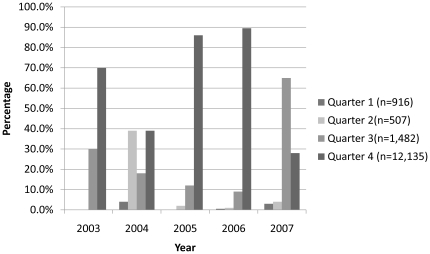
Quarterly distribution of the percentage of Dengue IgM positive cases by year.In 2003, Dengue IgM positive cases were only observed to appear in the months of July- December. This trend changed from 2004–2007, when IgM positive cases were detected throughout the year. Dengue IgM positive cases were most prevalent in the fourth quarter (October–December) from the years 2003 to 2006.